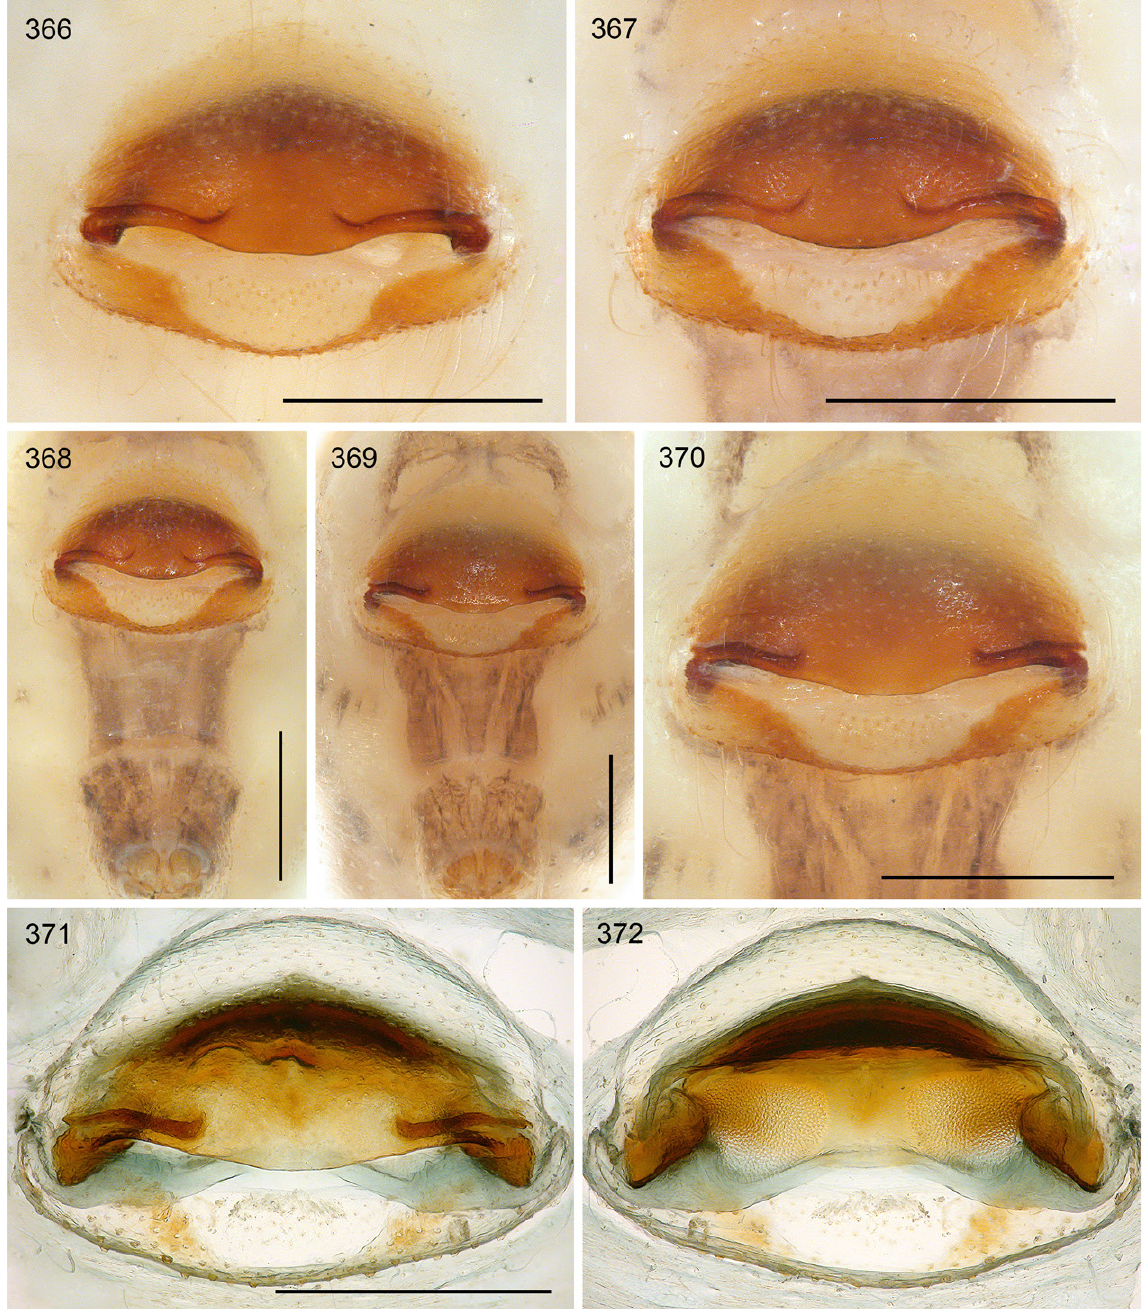
Figs 366–372. Crossopriza soudanensis Millot, 1941, paralectotypes. 366–367 . Epigyna, ventral views, females from Burkina Faso, Ouagadougou (366; MNHN Ar 10520) and from Mali, Sangha (367; MNHN Ar 10518). 368–369 . Abdomens, ventral views, females from Burkina Faso, Ouagadougou (368; MNHN Ar 10520) and from Mali, Bamako (369; MNHN Ar 10512). 370 . Epigynum, ventral view, female from Mali, Bamako (MNHN Ar 10512). 371–372 . Cleared female genitalia, ventral and dorsal views, female from Mali, Bamako (MNHN Ar 10512). Scale bars = 0.5